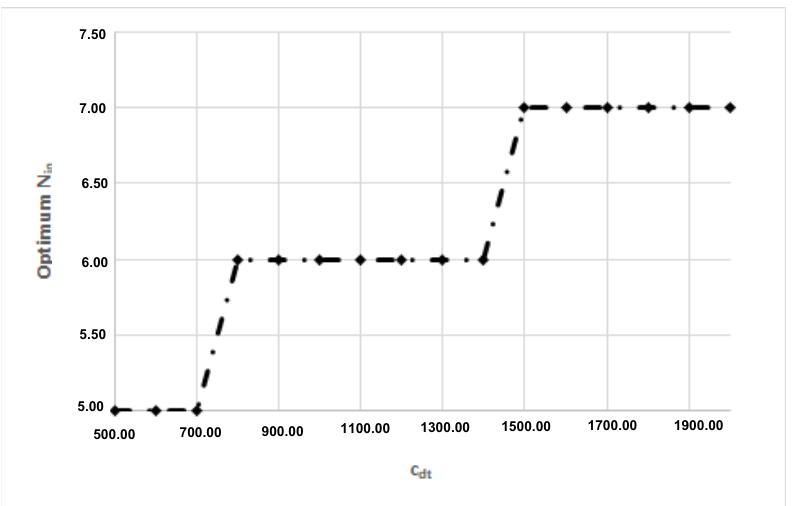
Figure 19. Variations of optimum N in per c dt